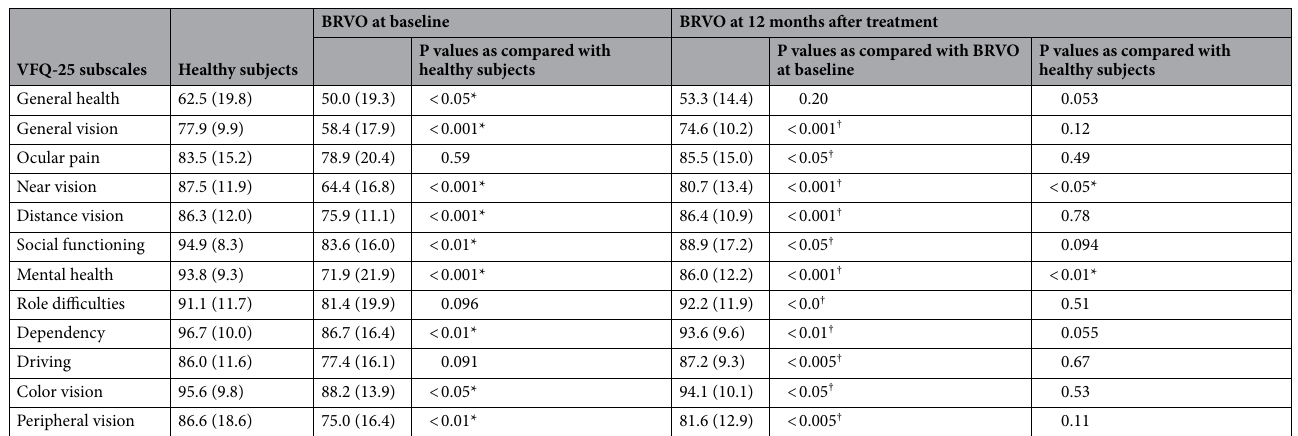
Table 2. The National Eye Institute 25-item visual function questionnaire subscales in healthy subjects and in patients with branch retinal vein occlusion at baseline and at 12 months after treatment. Scores presented as mean (standard deviation). VFQ-25 25-Item Visual Function Questionnaire. *Significantly different from the healthy subjects (Mann–Whitney U test). † Significantly different between BRVO at baseline and at 12 months after treatment (Wilcoxon signed-rank